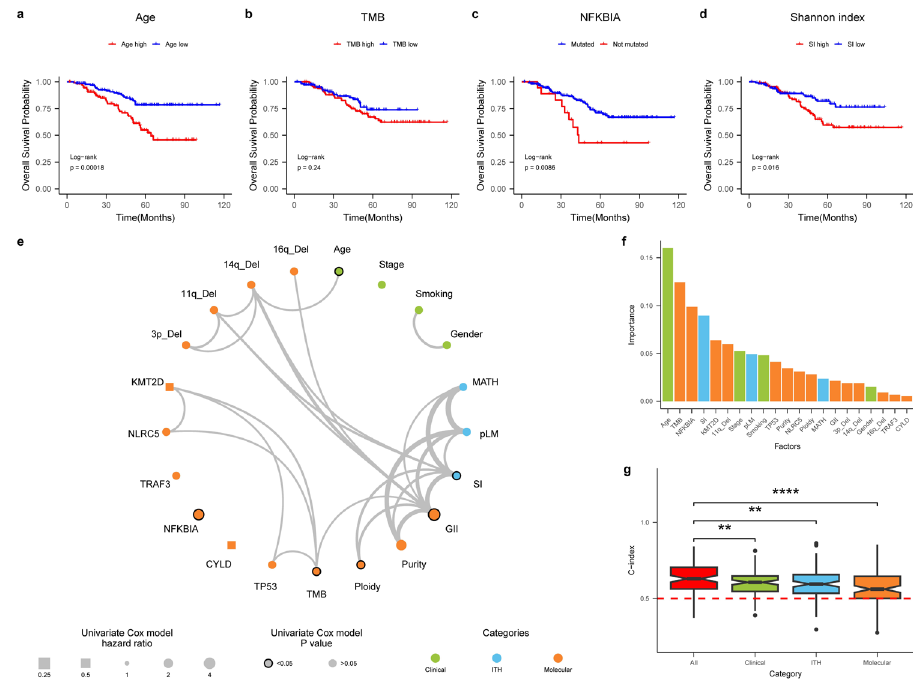
Figure 5. Integrative survival model. ( a – d ) The exemplar variables that can stratify patient survival from clinical (age), molecular (TMB), driver (NFKBIA), tumor heterogeneity (ITH). ( e ) The correlation network plot for the features across clinical, molecular as well as tumor heterogeneity (ITH) layers. Line widths marked the significance of the correlation. The dot sizes represented the hazard ratio in the univariate Cox model and margins around the symbols labeled the significance. ( f ) Importance of different features across the clinical, molecular as well as ITH features. ( g ) The predictive accuracy (c-index) of individual models consisting of different features. **/**** labeled statistical differences at p -values of 0.01 and 0.0001.